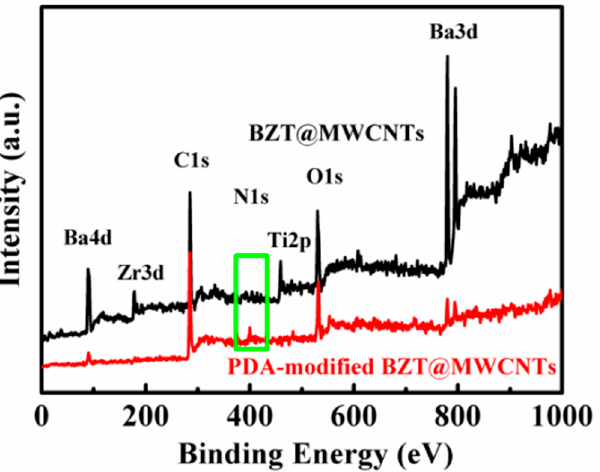
Figure 4. XPS spectra of BZT@MWCNTs and PDA-modified BZT@MWCNTs nanoparticles.